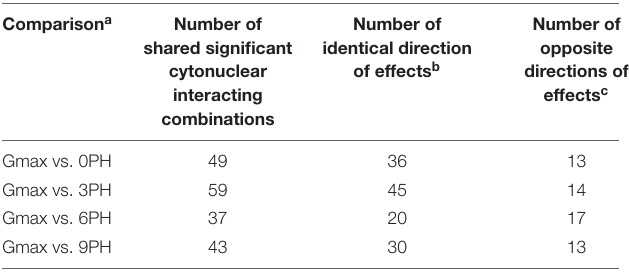
TABLE 3 | Comparison of directions of effects of cytonuclear interacting combinations significant both in the dormancy and germination performance experiments.